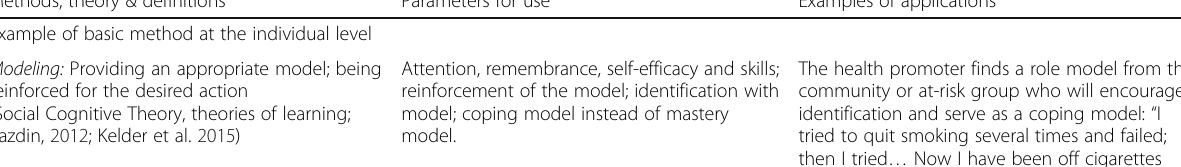
Table 2 A selection of methods, parameters, and examples of applications (Bartholomew Eldredge et al., 2016; Kok et al., 2016) Methods, theory &